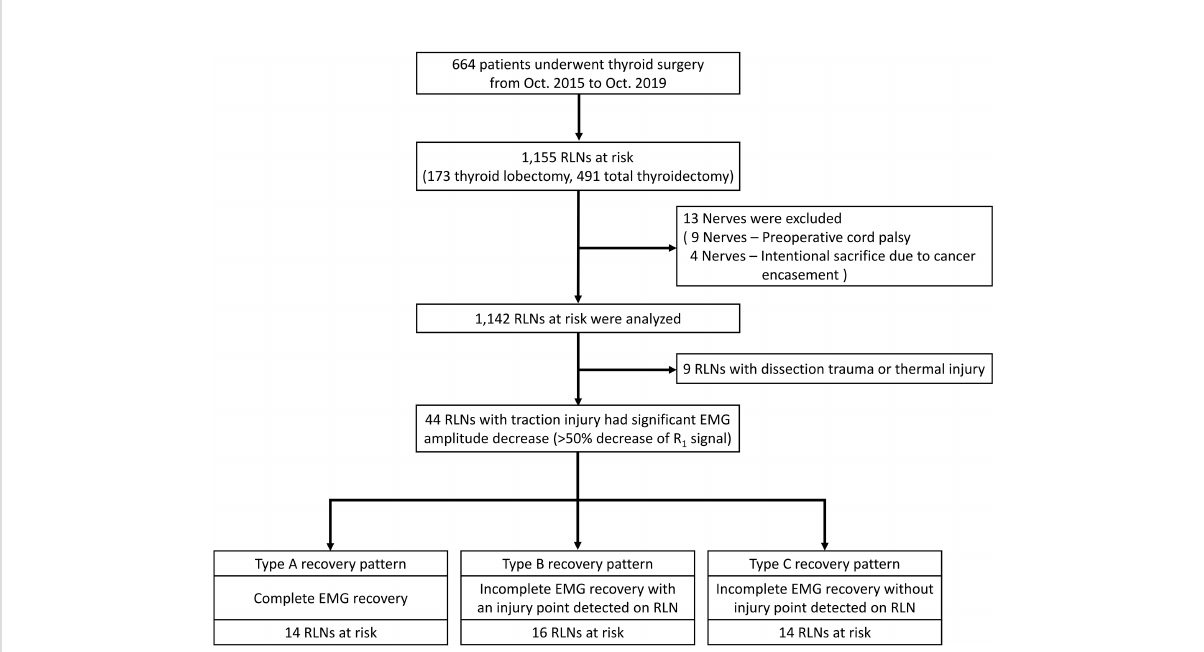
FIGURE 1 Flowchart of the procedure for the inclusion and exclusion of patients and the patterns, de fi nitions, and patient distribution summarized from this study. RLN= Recurrent laryngeal